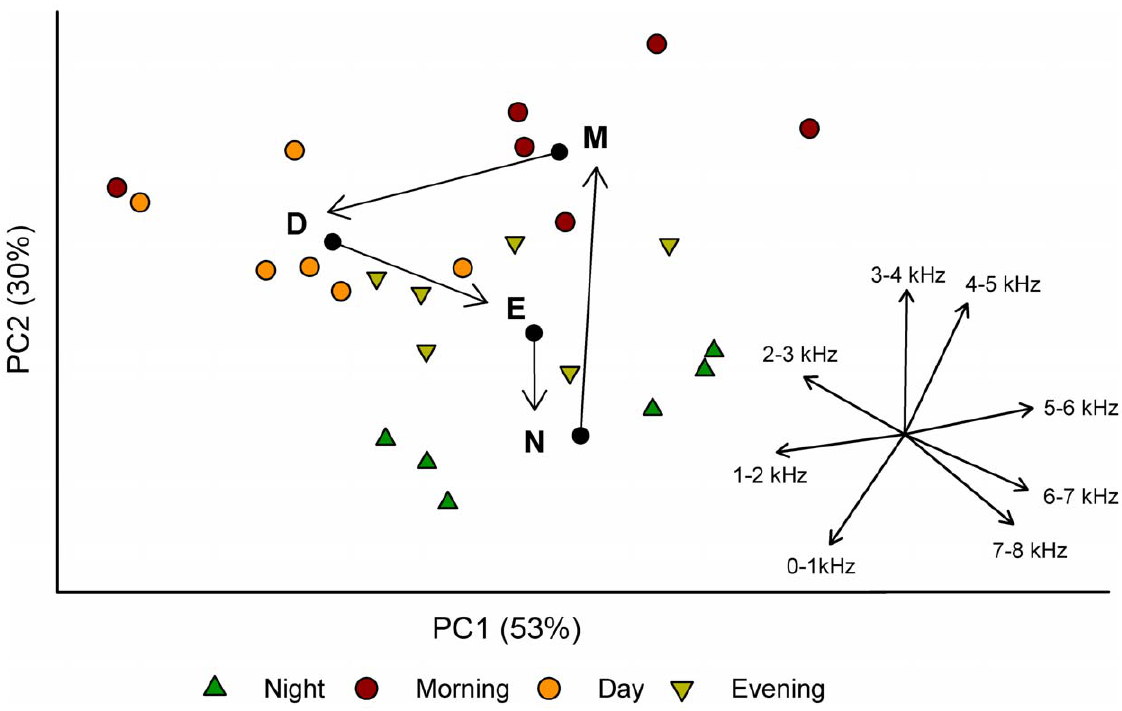
Figure 5. Changes in importance of frequency intervals by time period for a single lake. Principal component analysis summarizing patterns of relative power in eight frequency intervals using all 24 time selections for Morton Lake (urbanization=40%). Labels delineate the multivariate centroid for individual data points for each time period: Night (N), Morning (M), Day (D), and Evening (E). Inset displays the component loadings (eigenvectors) for each frequency interval.